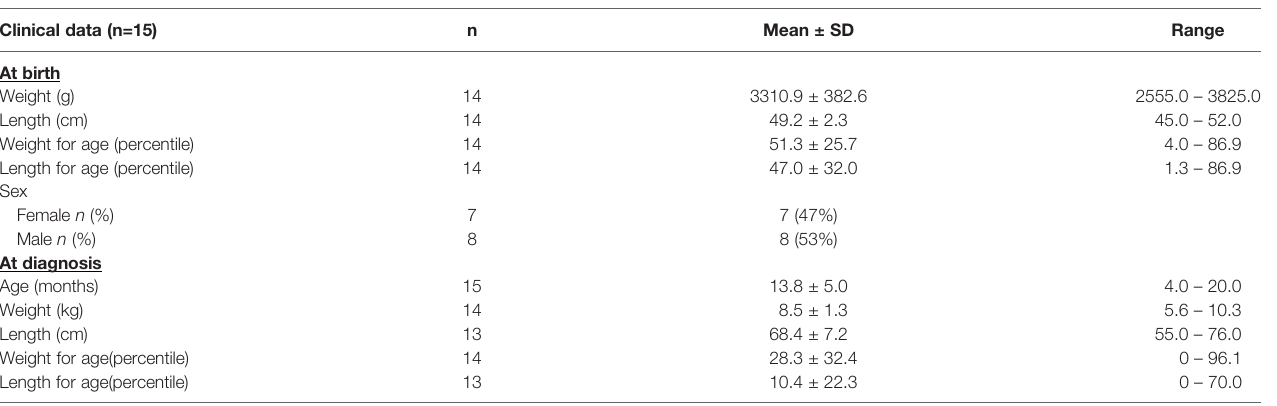
TABLE 4 | Characteristics of VDDR1A affected individuals for which medical records were